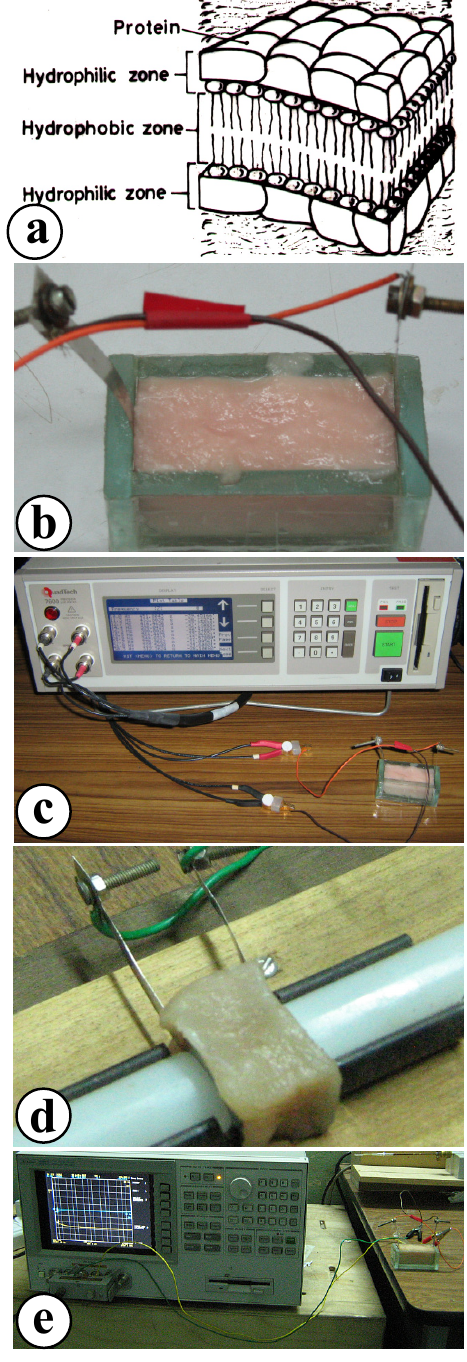
Figure-3: (a) animal cell membrane structure, (b) chicken muscle tissue paste in rectangular glass tank, (c) EIS study of chicken muscle tissue paste using QuadTech7600, (d) chicken muscle tissue block under EIS study using Agilent 4294A, (e) EIS study of chicken muscle tissue paste using Agilent